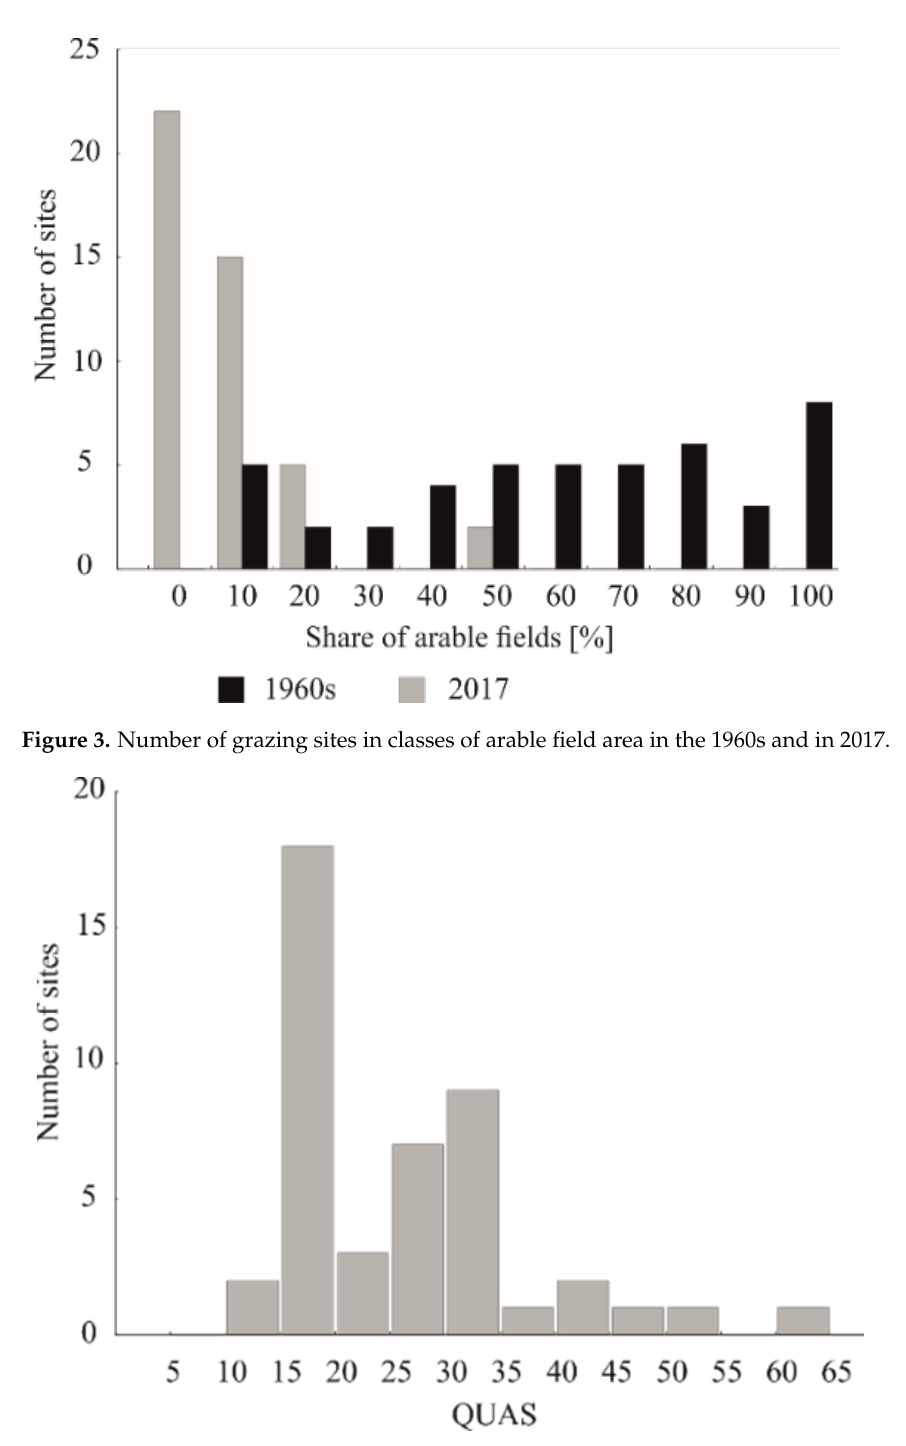
Figure 4. Number of grazing sites in classes of quality and usefulness of agricultural soils index (QUAS).